Question: Name the type of graph shown.
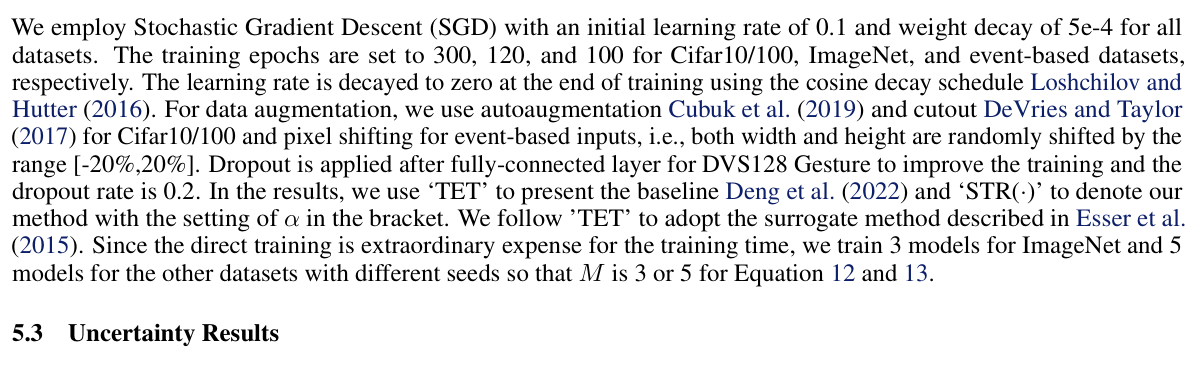
Answer: line